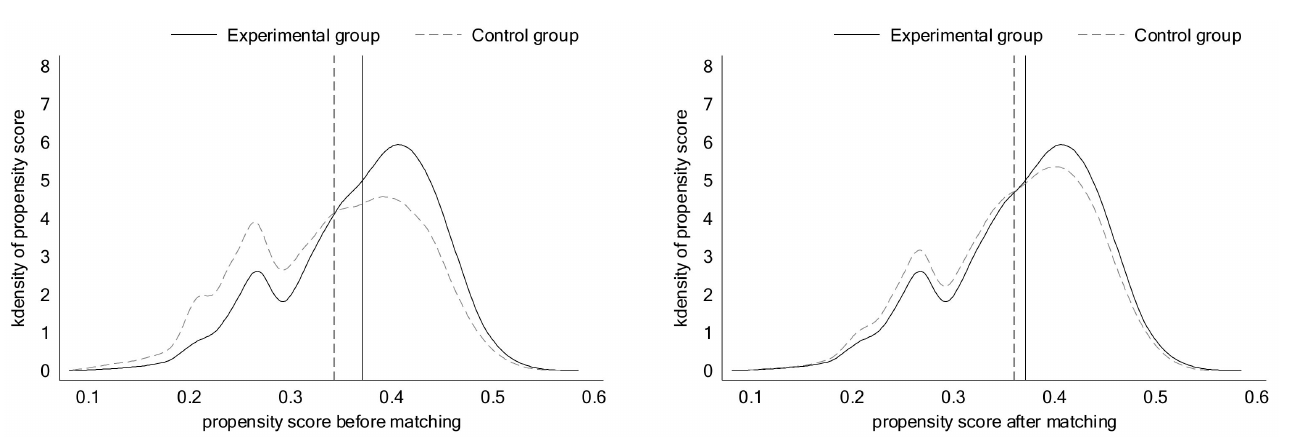
Figure 5. Before matching and after matching.